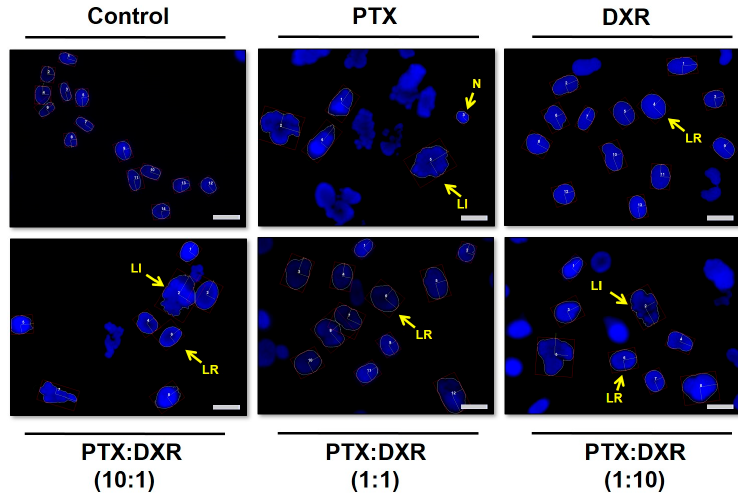
Figure 1. Fluorescence photomicrographs of MDA-MB-231 cell line nuclei stained with Hoescht 33342 after different treatments at concentration of 70 nM for 48 h. Some of the different nuclei morphometric phenotypes observed are indicated. Images are representative of three independent experiments. Amplification 40×, scale bar = 20 μ m. Abbreviations: DXR, doxorubicin; PTX, paclitaxel; N, normal; LI, large irregular; LR, large regular.